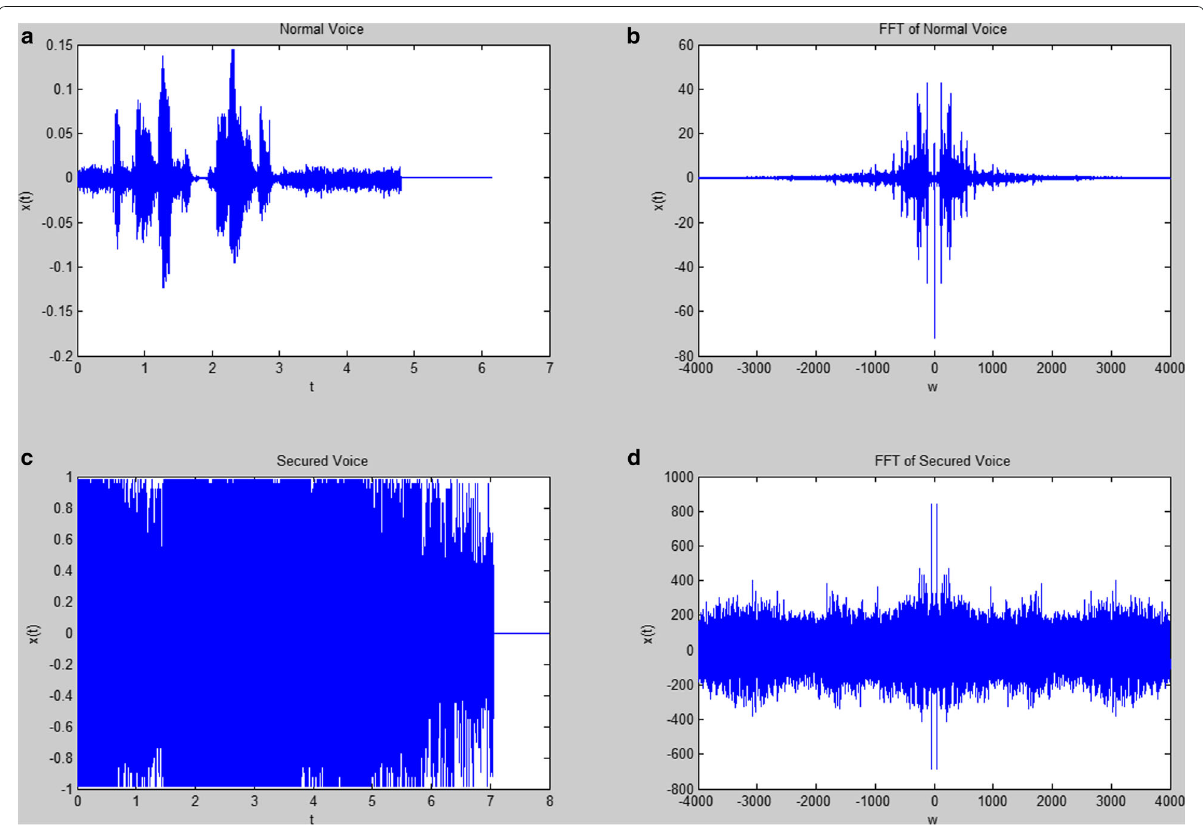
Fig. 8 Original and secured voices and their FFT versions. a Normal voice. b FFT of normal voice. c Secure voice. d FFT of secure